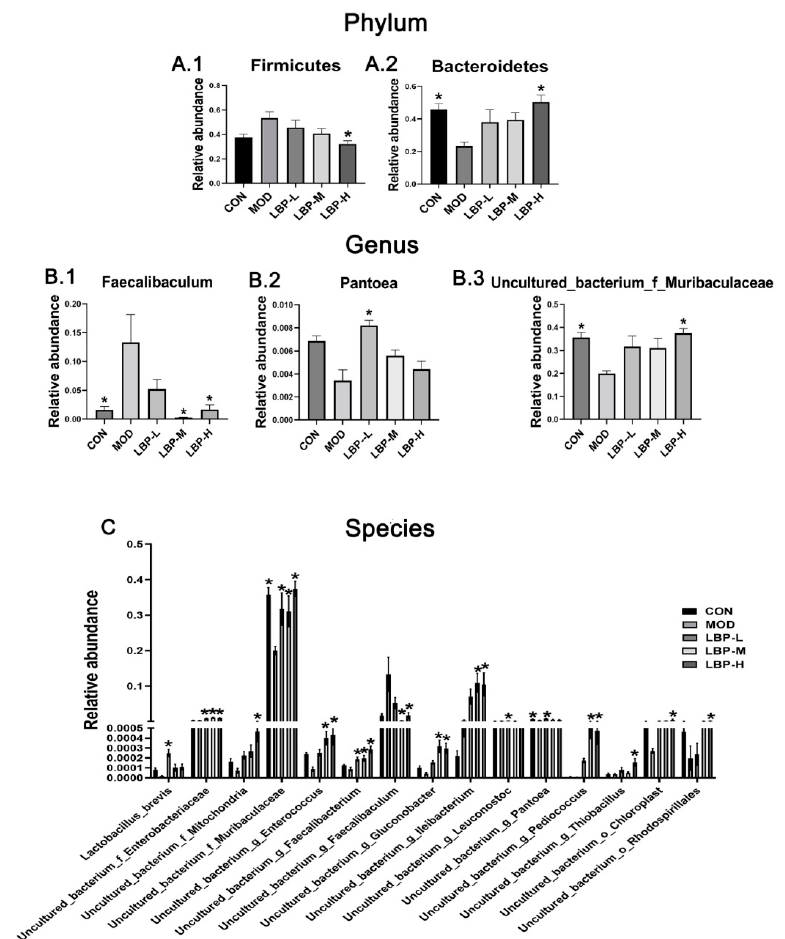
Figure 5. Effects of LBP feeding on gut microbiota at phylum, genus, and species levels (( A – C ), respectively) in high-fat diet induced obese mice. LBP, Lycium barbarum polysaccharide; *, p < 0.05, compared with the model group (MOD). Sample size for each group = 6.